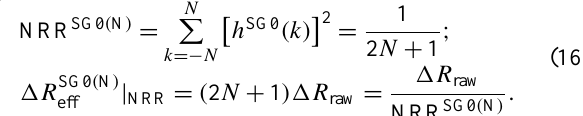
Figure 11. The input SNR of a test signal is shown with the black- squares line. The SNRs after applying an SG0 smoothing filter with different values of N are shown with blue-squares lines. The SNRs of the signal smoothed using a Gaussian filter with a σ that satis- fies Eq. (18) are also drawn with red-squares lines. Note the good agreement between the blue-squares and red-squares